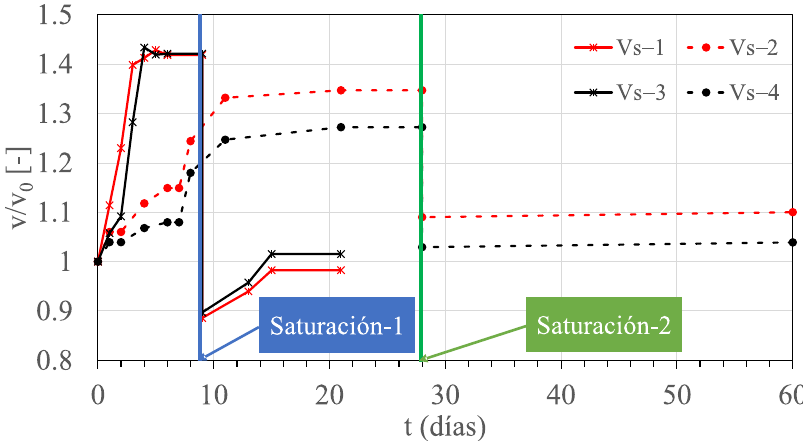
Figure 11. Wave velocity evolution in Maicillo treated with MICP .